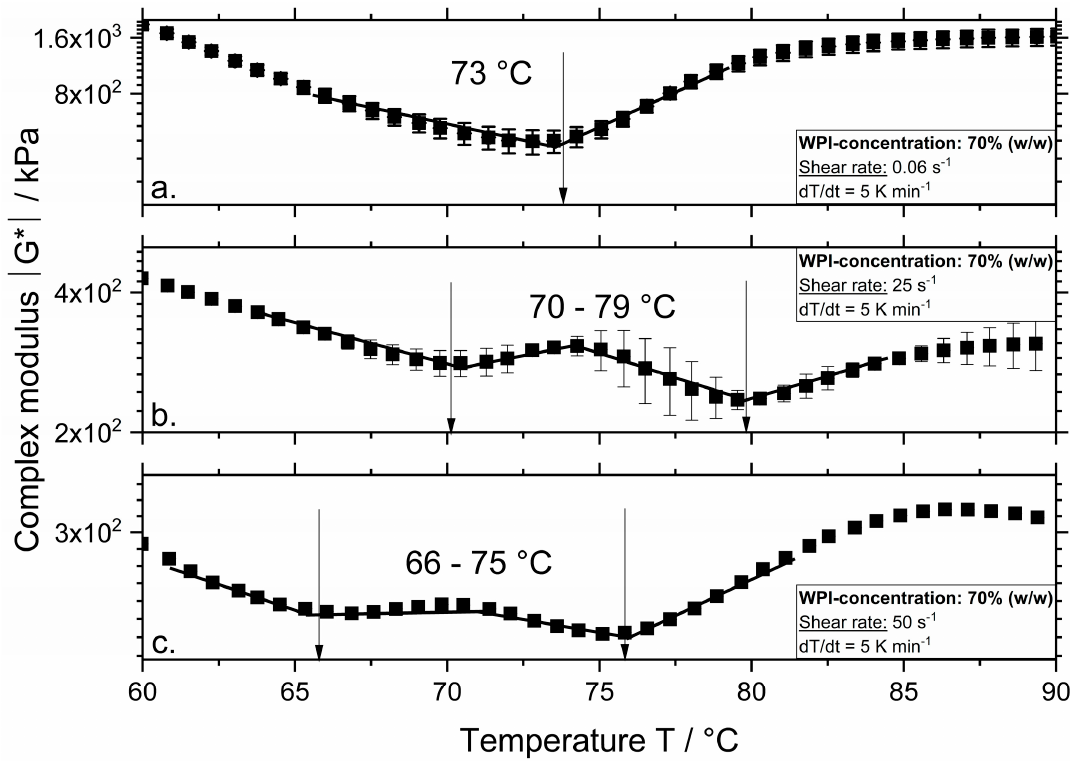
Figure 1. Complex modulus | G ∗ | as a function of temperature for systems with a whey protein isolate (WPI) concentration of 70% ( w / w ) and a shear rate of 0.06 ( a ), 25 ( b ), and 50 s − 1 ( c ). Measurements were performed at a constant heating rate of 5 K min − 1